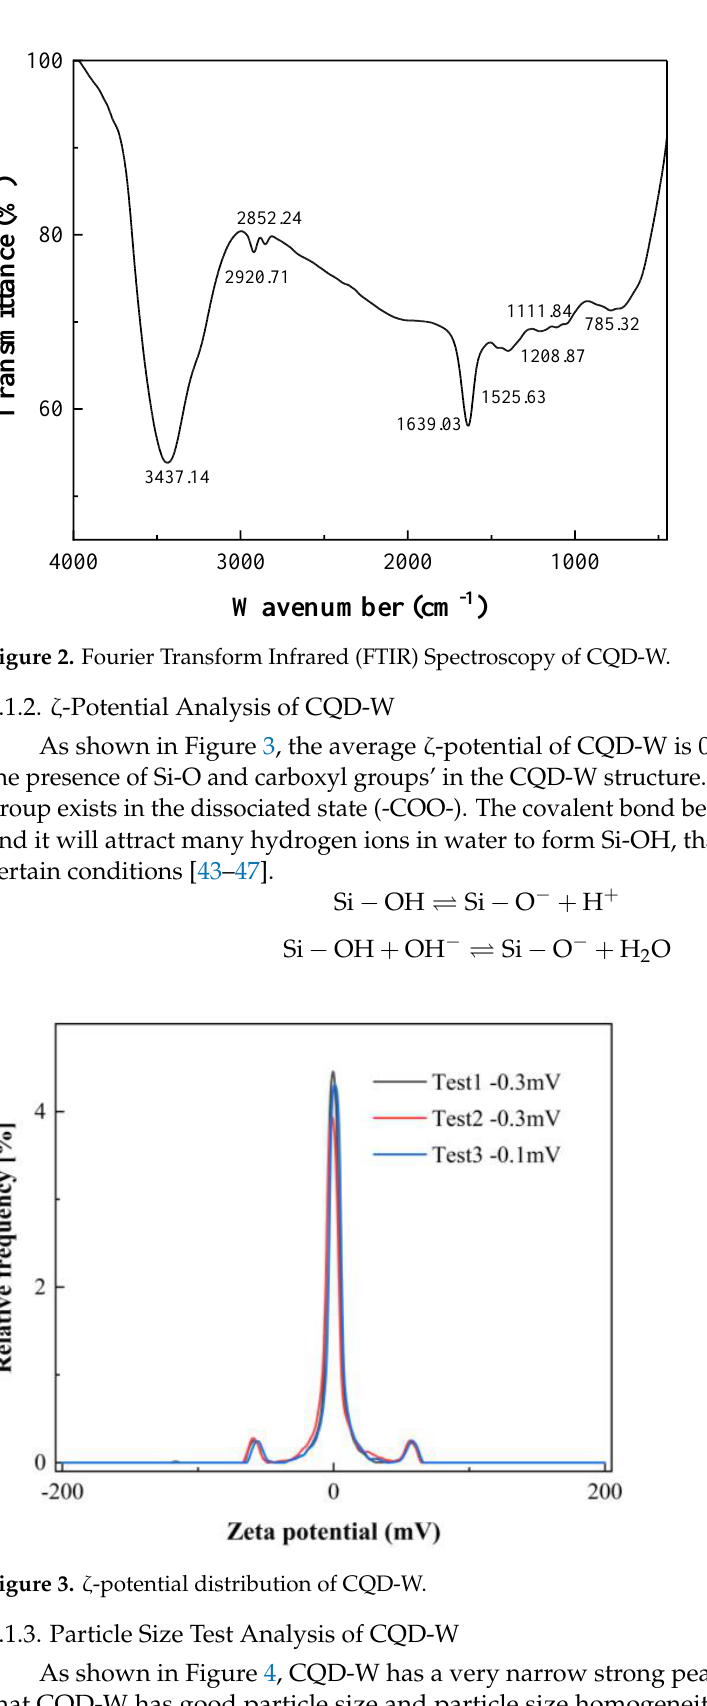
Figure 3. ζ -potential distribution of CQD-W.